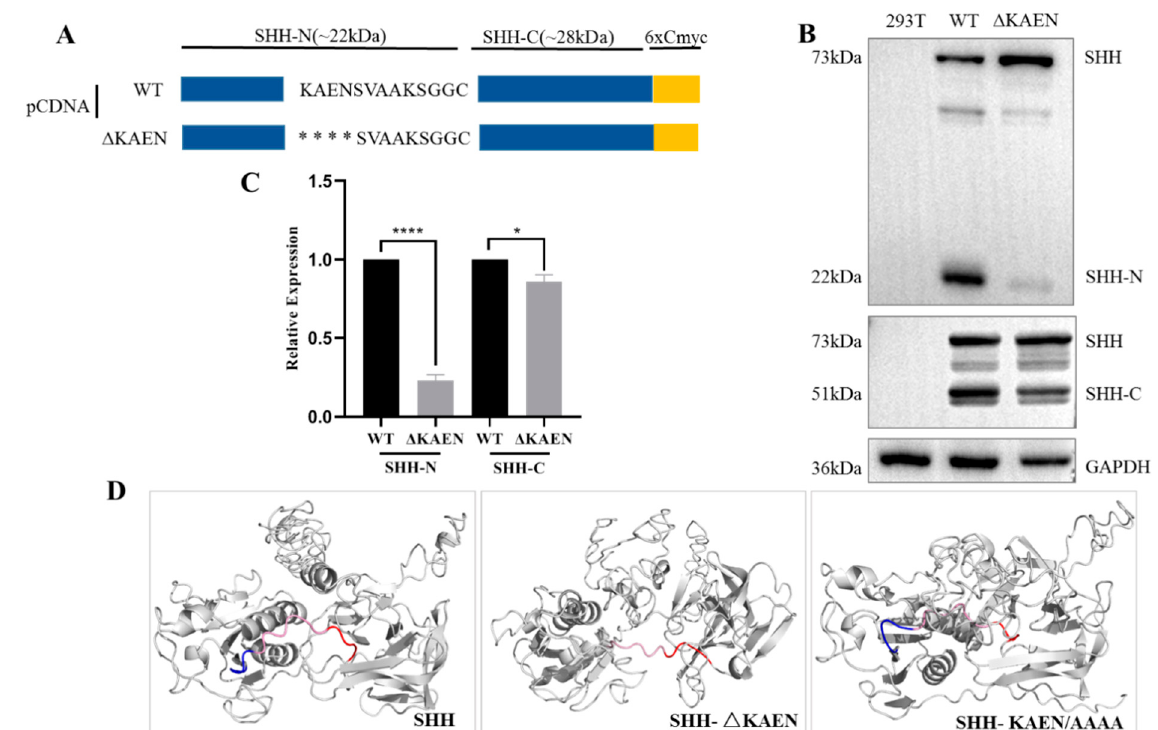
Figure 5. K186, A187, E188, and N189 affect SHH self-cleavage. ( A ) Schematic of WT and Δ KAEN constructs of SHH. * truncated amino acids. ( B , C ) Western blot and statistical analysis showed that SHH-N almost disappeared, and the expression of SHH-C decreased remarkably when KAEN was knocked out. Data are mean ± s.e.m, n = 3, * p < 0.05, **** p < 0.0001. ( D ) Structural simulation of SHH protein showed that the C -terminal region, including self-cleavage site between G200 and C201 (blue, KAEN; pink, SVAAKS; red, GGCF) was presented on the surface as α -helices in WT but covered and changed to an aperiodical coil in KAEN truncation and KAEN/AAAA replacement. This finding indicated that the KAEN region was critical for the surface presentation of the cholesterol modification site, similar to that of IHH.